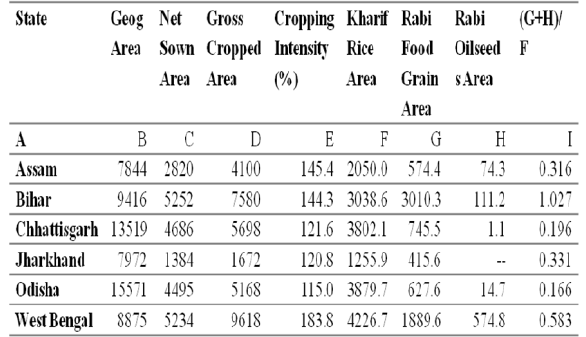
Table 1. Land Use and Crop statistics of selected States for 2013-14 A ratio of rabi food grain and oilseeds area with kharif rice area shows Odisha has lowest ratio, followed by Chhattisgarh, indicates these two states have high post kharif rice fallow area (Table 1). An estimate by National Mission on Oilseeds and Oil Palm (NMOOP) shows that, among these six states Odisha has highest area of rice fallows (2.961 MHa), followed by